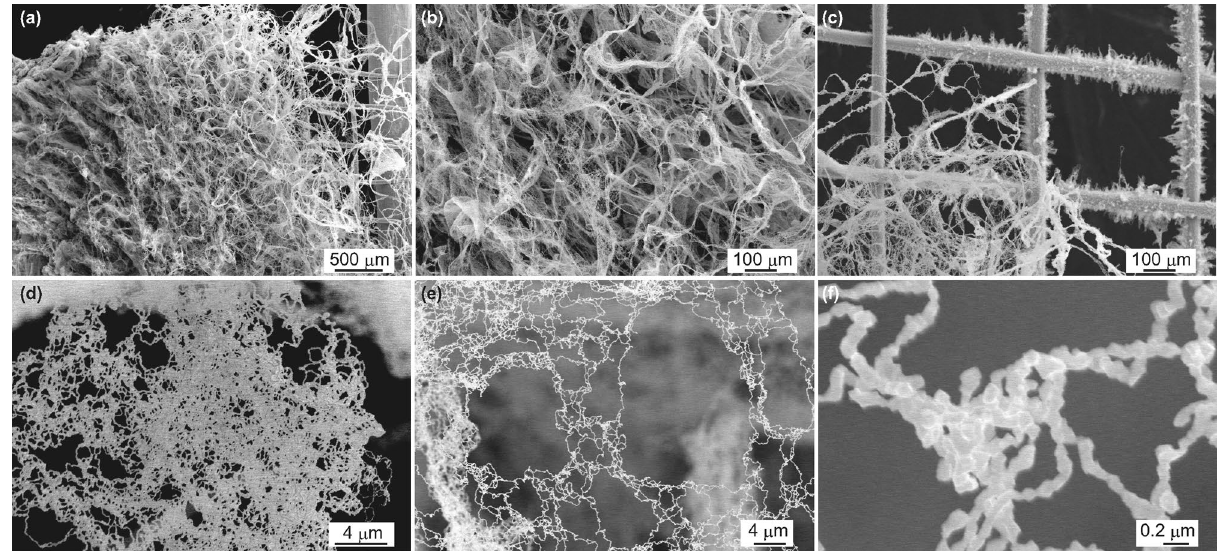
Figure 4. SEM micrographs of LFNs formed on the ♯ 50 mesh at various magnifications (at low magnification ( a – c ) and high magnification ( d – f